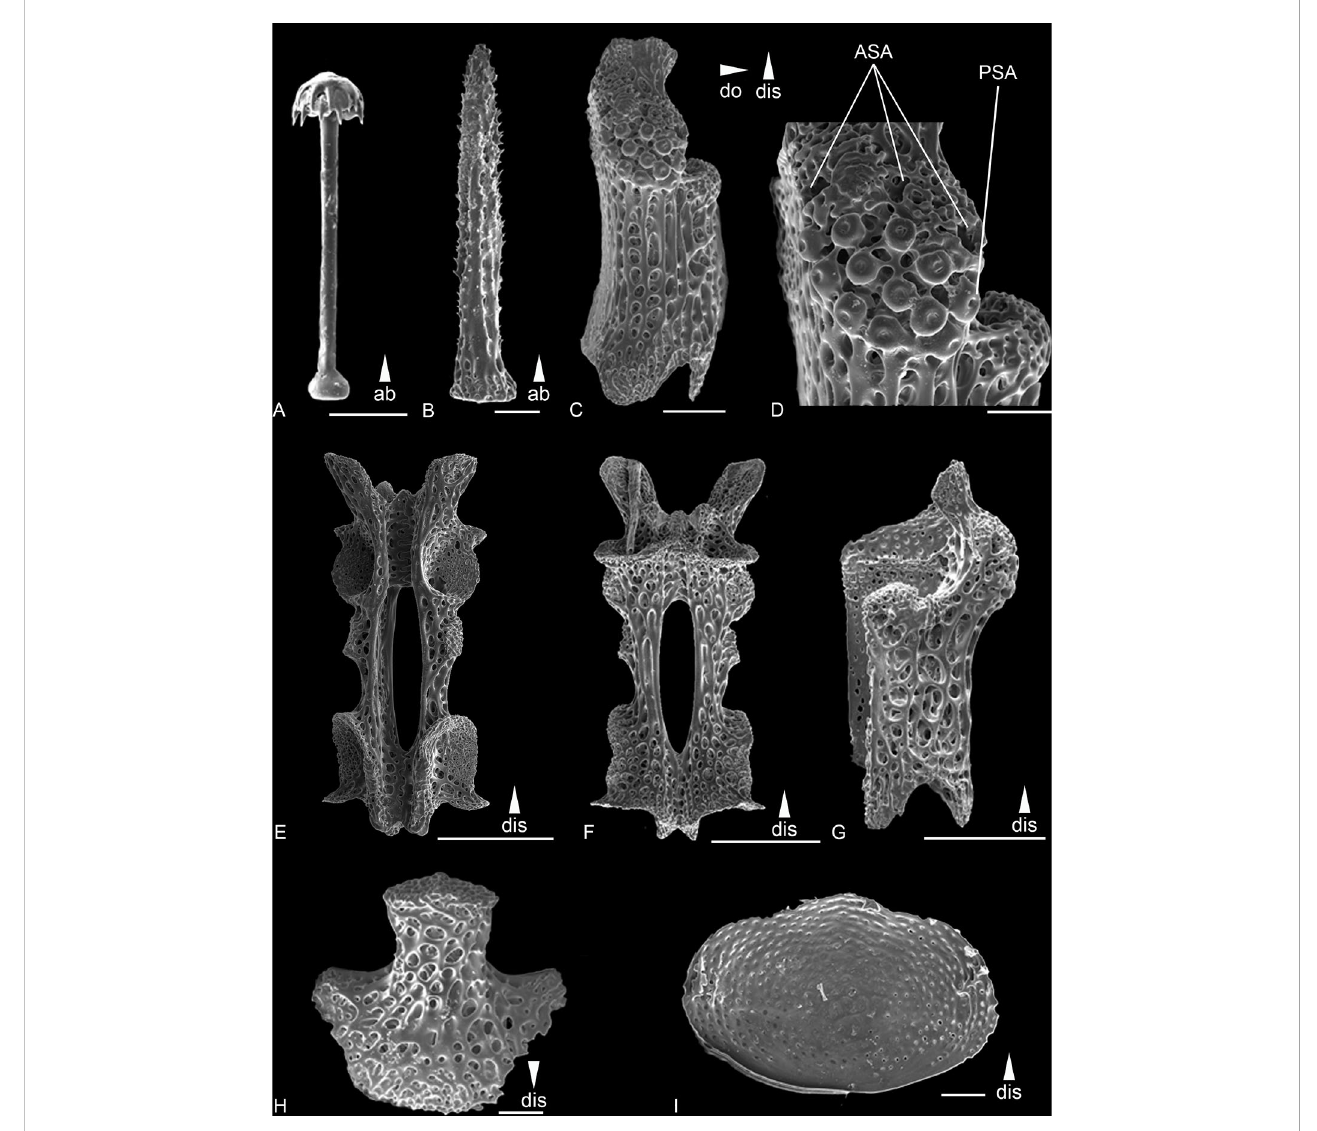
FIGURE 8 Scanning electron microscope images of the ossicles from Ophiotholia saskia sp. nov. (AB2_EB1_13_21). (A) : Parasol-spine; (B) : Arm spine; (C) : Lateral arm plate lateral; (D) : Close up lateral arm plate; (E) : Arm Vertebrae ventral; (F) : Arm Vertebrae dorsal; (G) : Lateral arm plate dorsal; (H) : Ventral arm plate. (I) dorsal arm plate ventral side. Scales: 50 µm (A, B, D, H, I) ; 200 µm (C, E – G) ;. ab, abradial; ASA, arm spine articulation; dis, distal; PSA, parasol spine